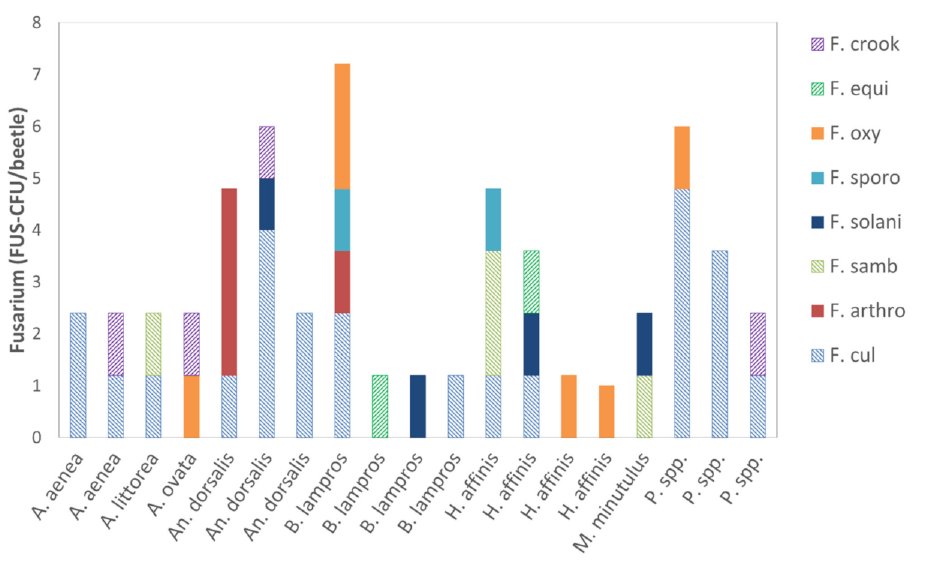
Figure 4. Composition of Fusarium (F.) species on the body surface of carabid beetles, detected with a culture-dependent method. Fully colored bars represent Fusarium species that produce only macroconidia, striped bars represent Fusarium species that produce macro- and microconidia. Species code: F. crookwellense (F. crook), F. equiseti (F. equi), F. oxysporum (F. oxy), F. sporotrichioides (F. sporo), F. solani (F. solani), F. sambucinum (F. samb), F. arthrosporioides (F. arthro), F. culmorum (F. cul). For carabid species, abbreviations see Table 1 (abbreviations long). Table 5. List of Fusarium (F.) , Alternaria (Al.) species, and their load in a number of CFU, detected on the body surface of 39 carabid beetles. Fusarium species were divided into two groups based on their ability to produce macro- and microconidia (Micro) or only macroconidia (Macro). Alternaria species were divided into two groups based on the amount produced low or high amounts of mycotoxins. Fungi Species Number of CFU Conidia